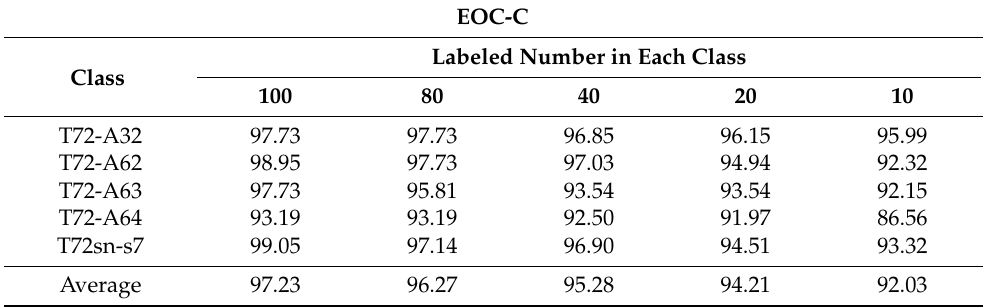
Table 6. Recognition accuracy (%) of EOC-C under different numbers of labeled images in each class.